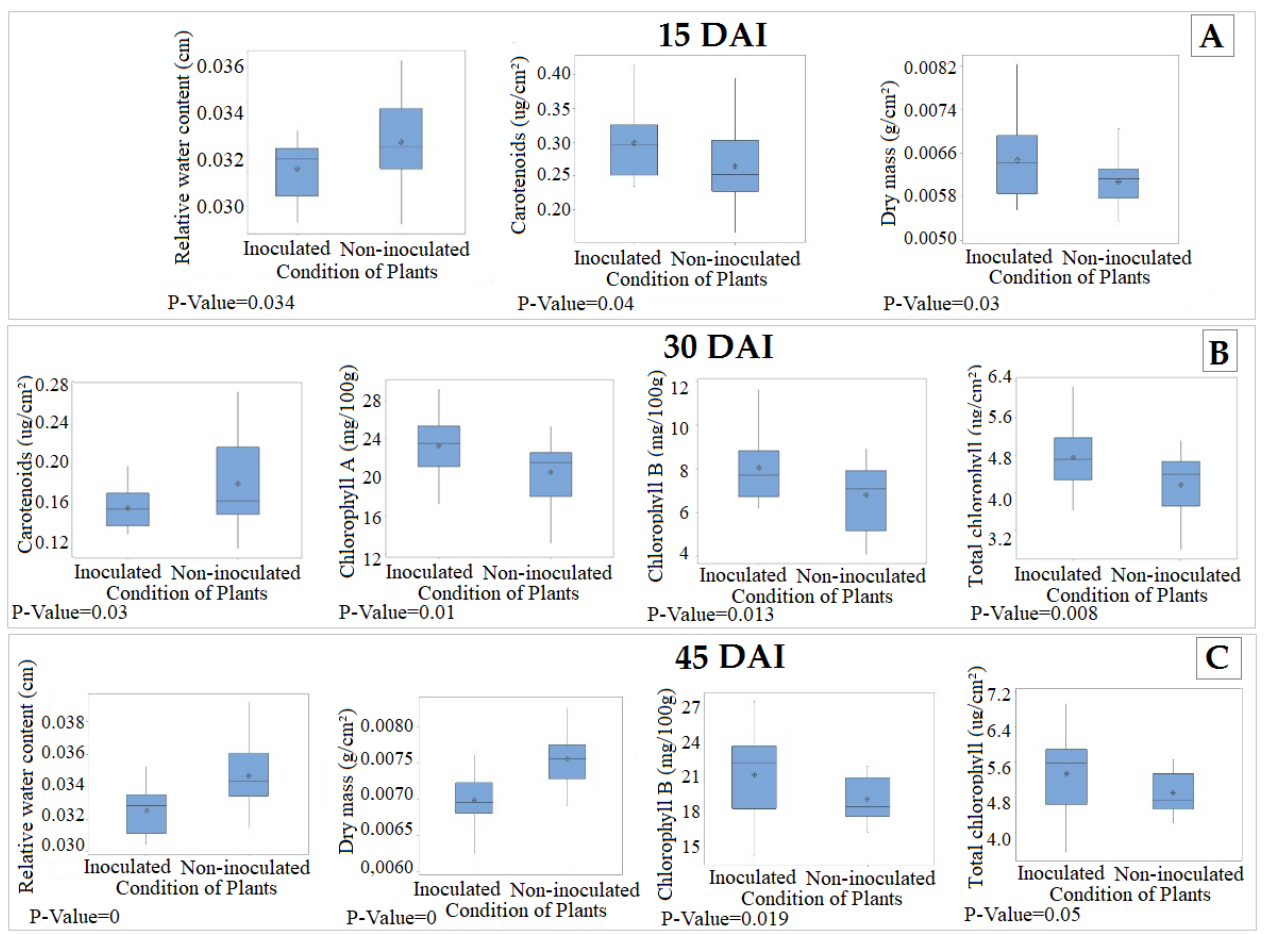
Figure 4. Distribution of minimum, maximum, and median values of significantly different physi- ological parameters at 15 ( A ), 30 ( B ), and 45 days ( C ) after